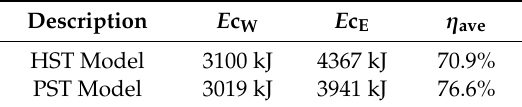
Table 8. Energy analysis of entire drive